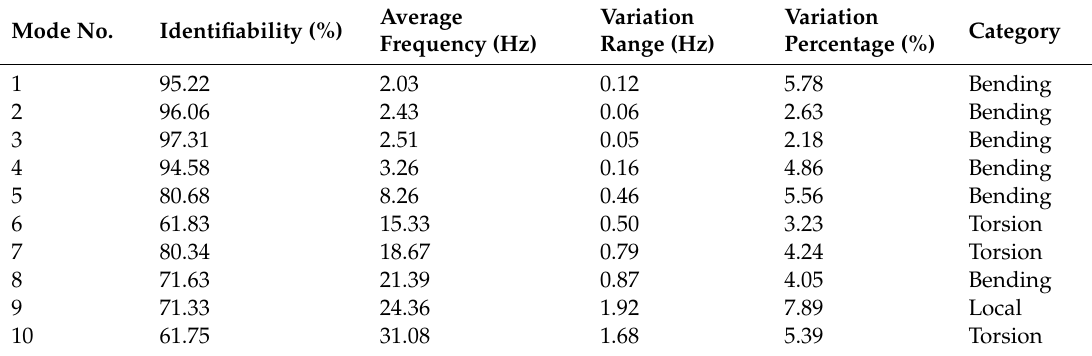
Table 1. Basic information of the ten target